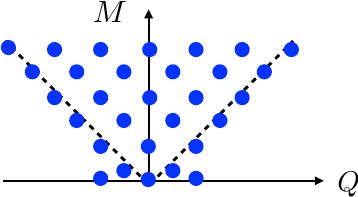
below a given mass scale than the abelian sLWGC does, as the latter can be satisfied by particles charged under a sparse set of representations, provided they are sufficiently